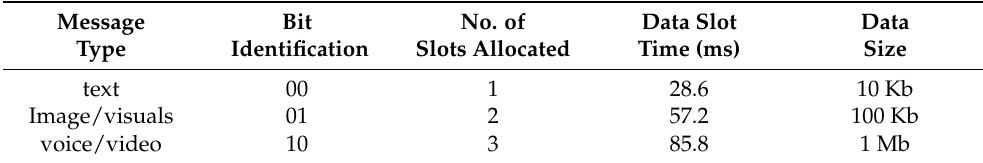
Table 11. Particulars of data messages with reference to slot and data size for N =